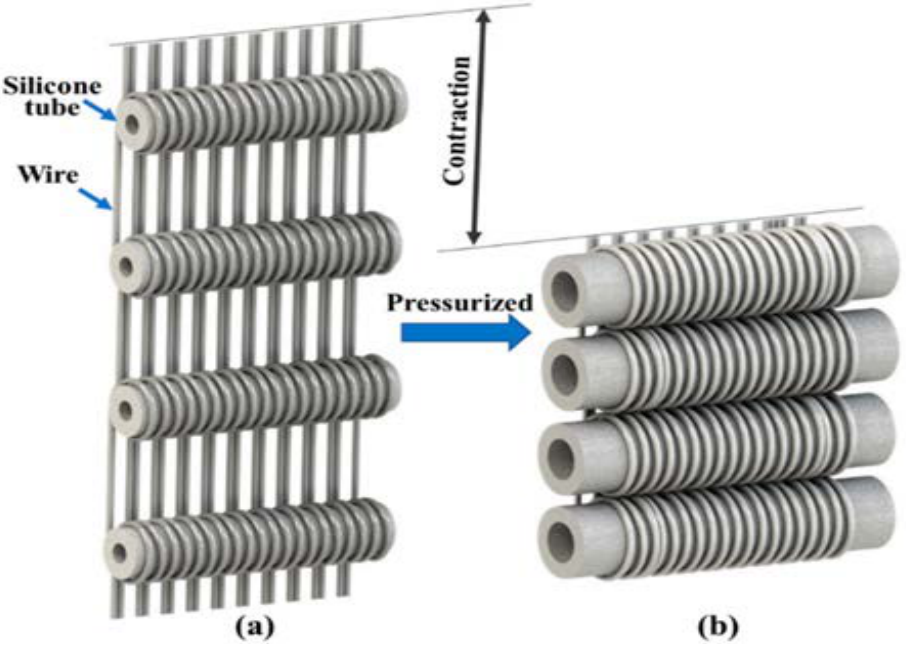
Figure 13. Novel winding artificial muscle driven by pneumatic silicone tubes, ( a ) shows the tubes at rest in a layout comprised of multiple silicone tubes with the wires sat within the grooves of the tubes. ( b ) shows the pressurized pneumatic assembly actuating causing the tubes to contract closer to one another (Reprinted with permission from Xie, D. et al. [126]). 2021, CC BY 4.0 Interna-